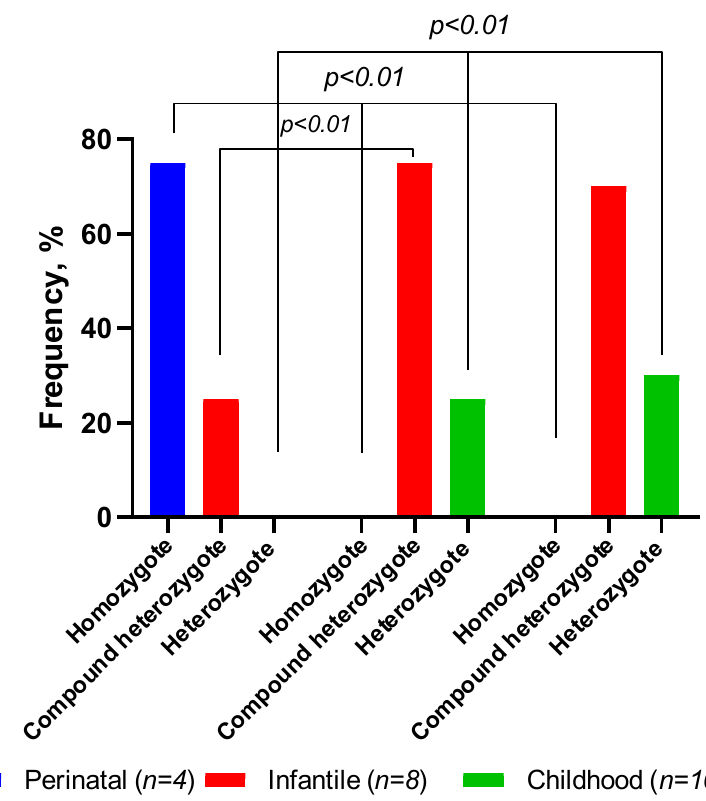
Figure 9. Frequency of the homozygous, compound-heterozygote, and heterozygote genotypes of the ALPL gene in patients, depending on the form of HPP.